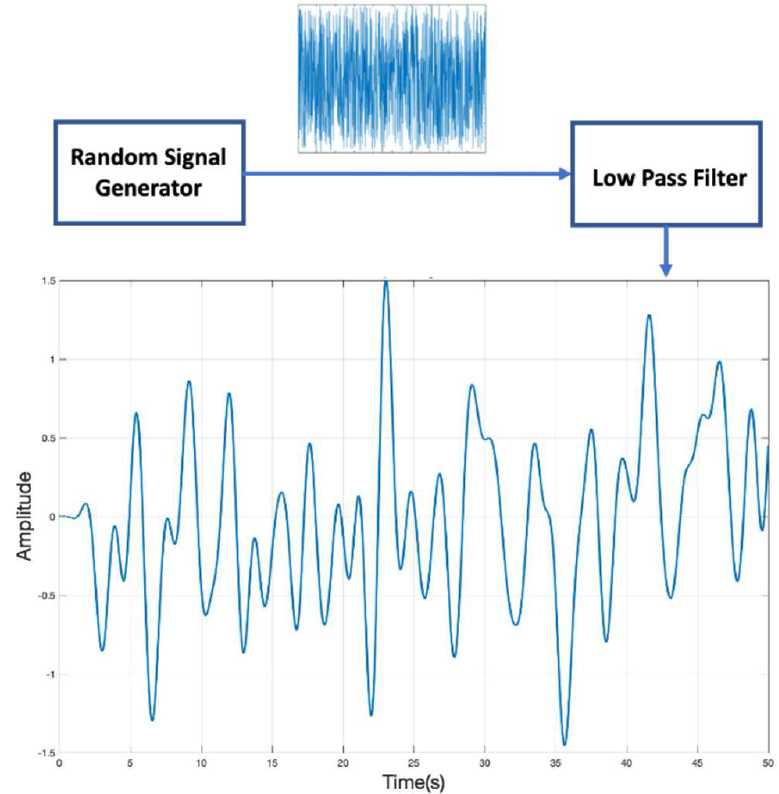
Figure 14. Randomized Low-Frequency Signal Generation.